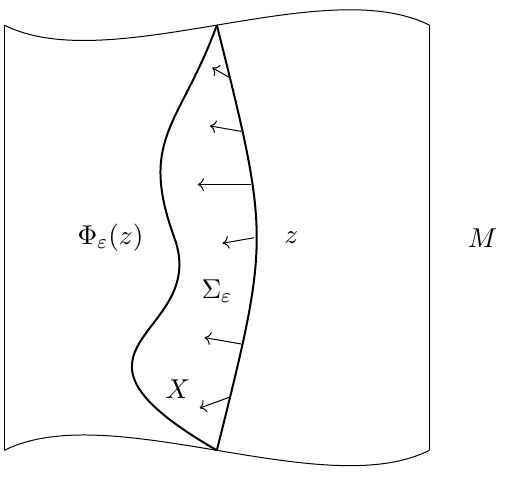
Figure 3 . Variation of the path z along a flow Φ s whose tangent vector field on z at s = 0 coincides with X . The trajectories Φ